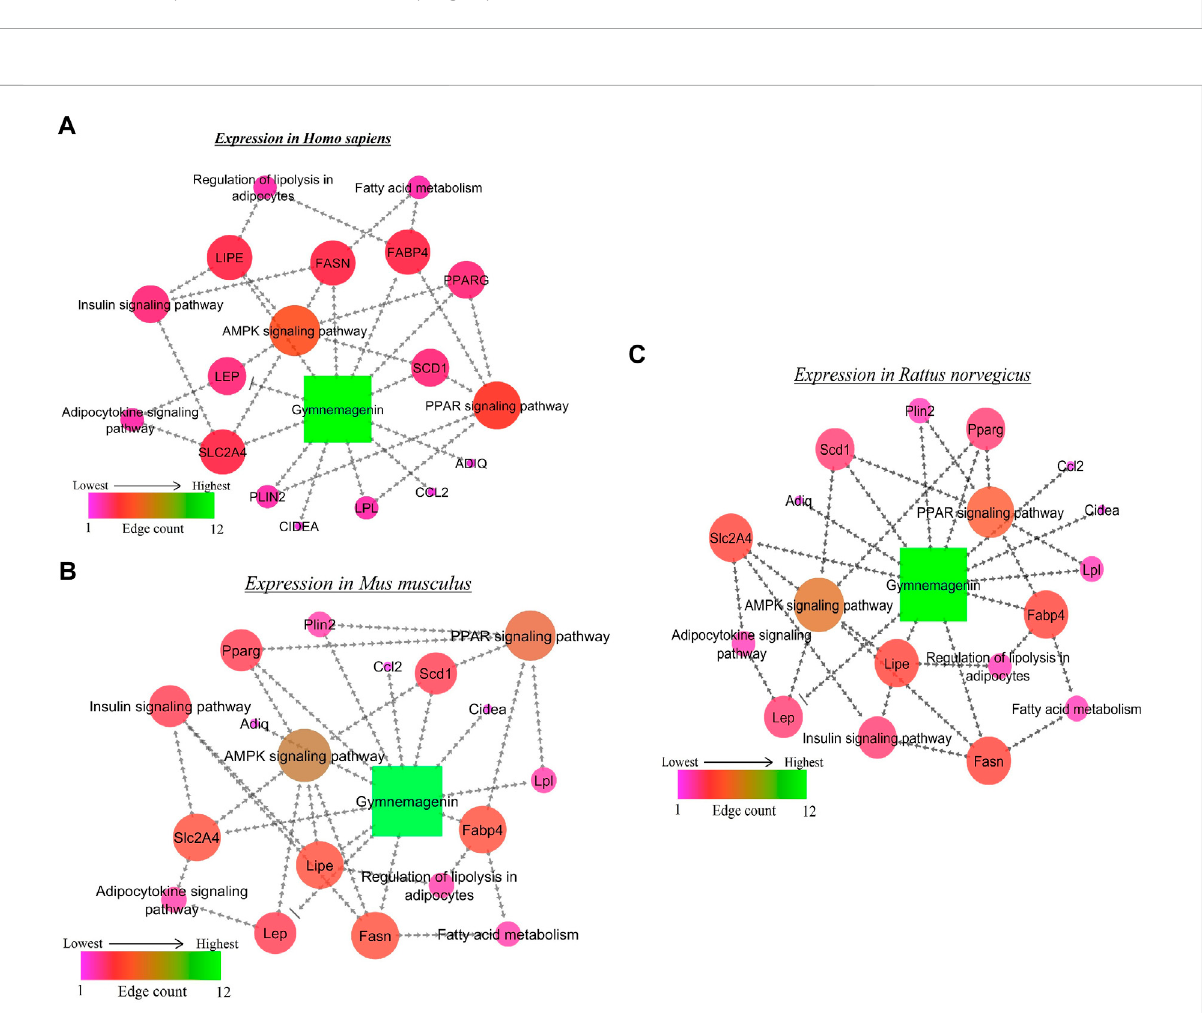
FIGURE 7 Networkrepresentationofgymnemagenin-modulatedgenesandpathwaysin (A) Homosapiens , (B) Musmusculus,and (C) Rattusnorvegicus. In the network interaction, the node with the higher edge is represented with green color, which gradually decreases to